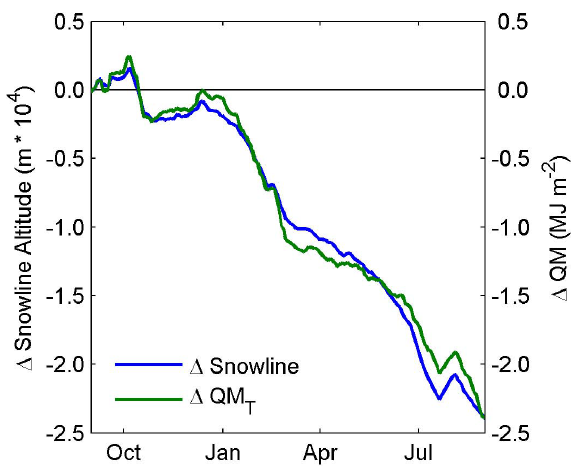
Fig. 12. Cumulative differences in maximal snow line altitude and total (surface + subsurface) melt energy (QM T ) between year 2 (September 2007–August 2008) and year 1 (September 2006– August